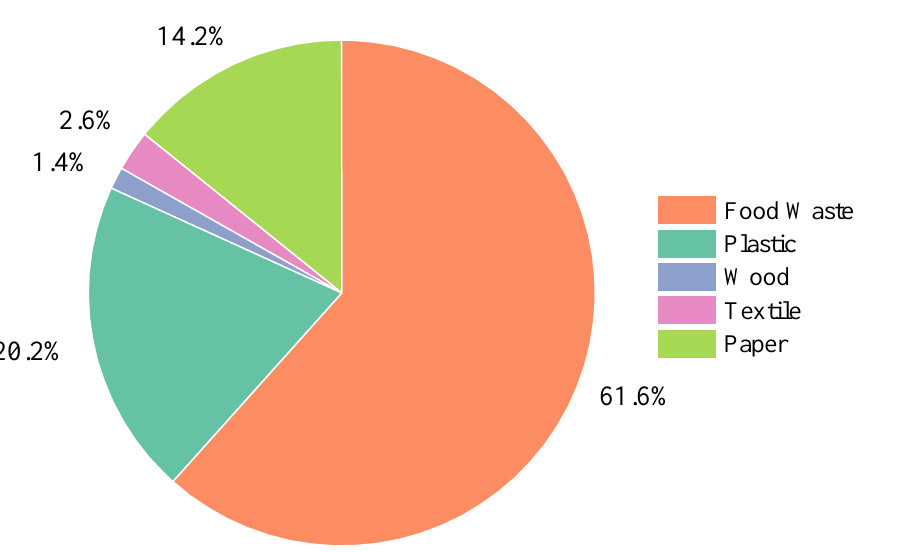
Figure 1. Composition of the synthetic RDF.